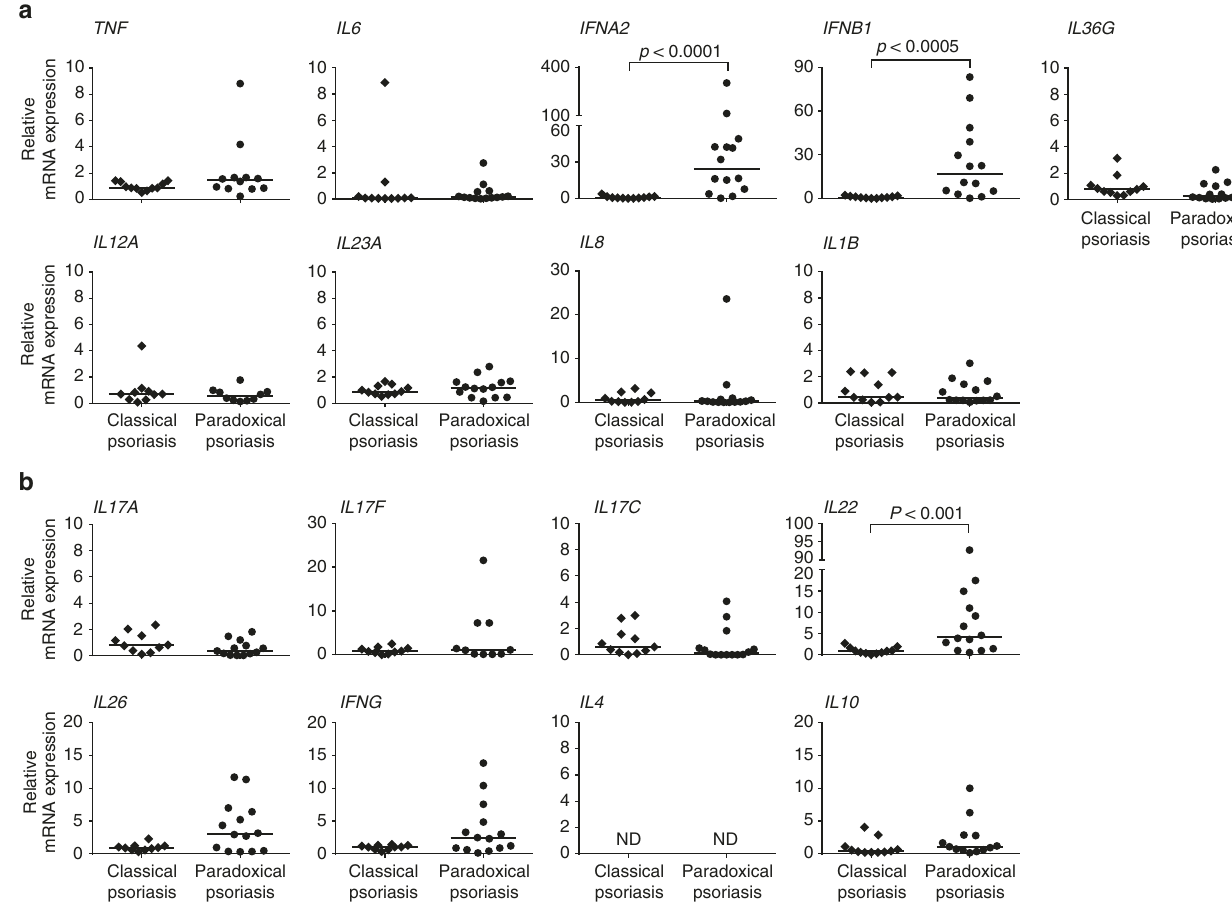
Fig. 2 Increased type I interferon in skin lesions of paradoxical psoriasis. a mRNA expression analysis of pro-in fl ammatory cytokines TNF , IL6 , IFNA2 , IFNB1 , IL36G , IL12A , IL23A , CXCL8 , and IL1B relative to GAPDH in skin lesions of paradoxical psoriasis compared to classical plaque psoriasis. b mRNA expression analysis of adaptive T-cell-derived cytokines IL17A , IL17F , IL17C , IL22 , IL26 , IFNG , IL4 , and IL10 relative to GAPDH in skin lesions of paradoxical psoriasis as compared to classical plaque psoriasis. Dots represent individual patient and horizontal bar denotes the median value. Data shown as mRNA expression level relative to mean expression in classical psoriasis (mean value for classical psoriasis was set at 1). Statistical analysis was performed with unpaired non-parametric Mann – Whitney U -test. ND = not